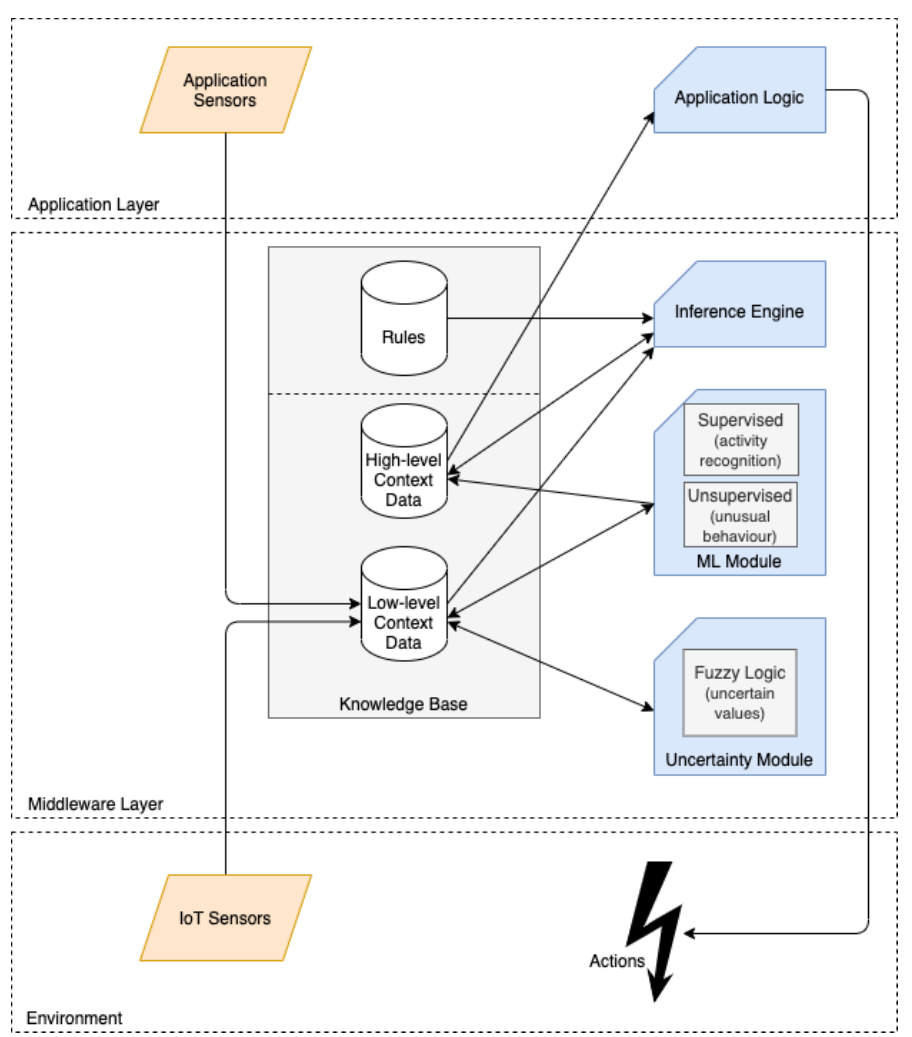
Figure 7. Architecture of context